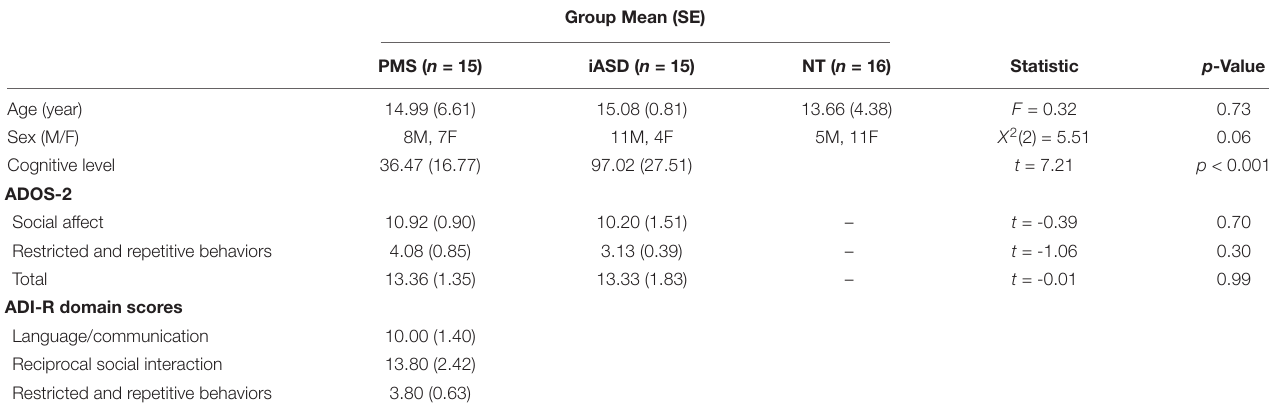
TABLE 1 | Clinical and demographic